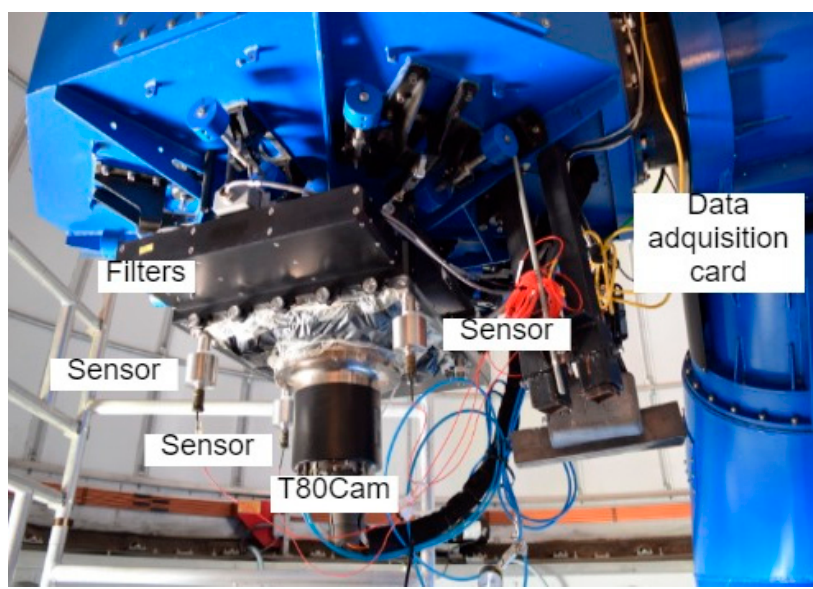
Figure 2. Detail of the T80Cam camera, filters, accelerometers, and data acquisition equipment.